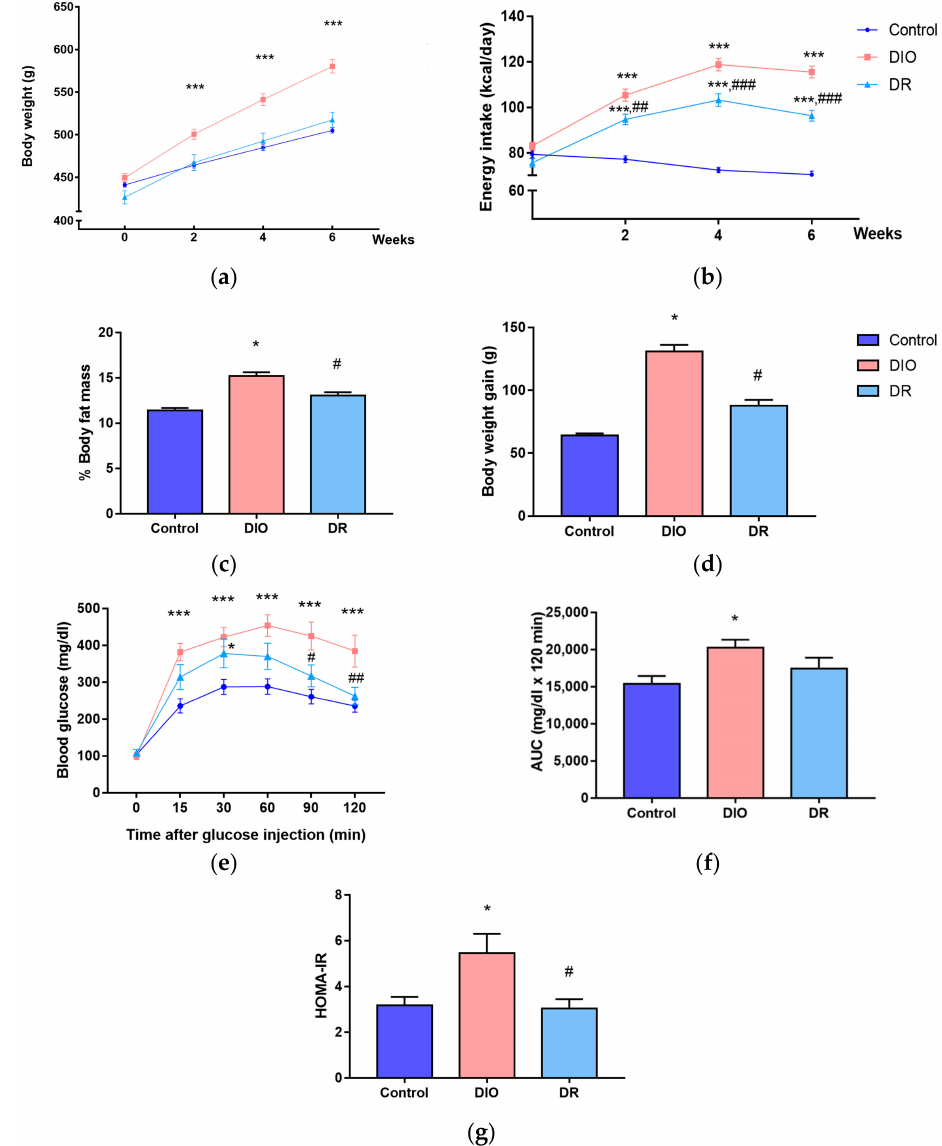
Figure 3. ( a ) The body weight (BW) of rats during diet manipulation for 6 weeks; *** represents statis- tical significance compared to other groups ( p < 0.001). ( b ) Energy intake during the 6-week period; *** represents statistical significance when compared to other groups ( p < 0.001), ## represents statisti- cal significance when compared to DIO rats ( p < 0.01), ### represents statistical significance when compared to DIO rats ( p < 0.001). ( c ) The percentage of body fat mass in each group; * represents sta- tistical significance when compared to the control group ( p < 0.05), # represents statistical significance when compared to DIO rats ( p < 0.05). ( d ) The body weight gain during 6 weeks of diet manipulation; * represents statistical significance compared to the control group ( p < 0.05), # represents statistical significance when compared to DIO rats ( p < 0.05). ( e ) Intraperitoneal glucose tolerance test (IPGTT) in control, DIO and DR rats; *, *** represents statistical significance when compared to the control group ( p < 0.05, p < 0.001, respectively), #, ## represents statistical significance when compared to DIO rats ( p < 0.05, p < 0.01, respectively). ( f ) Area under the curve (AUC) of IPGTT; * represents statistical significance when compared to the control group ( p < 0.05). ( g ) The calculated homeostasis model of insulin resistance (HOMA-IR) in control, DIO and DR rats; * represents statistical significance when compared to the control group ( p < 0.05), # represents statistical significance when compared to DIO rats ( p < 0.05). All results are presented as mean ± SEM; n = 12 per group (control and DIO rats), n = 10 per group (DR